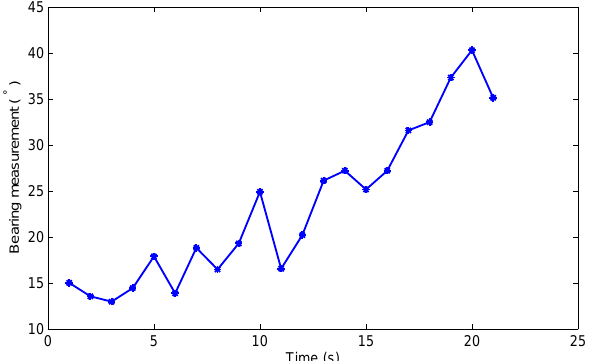
Figure 2. The measurement of the target in Scenario 1.